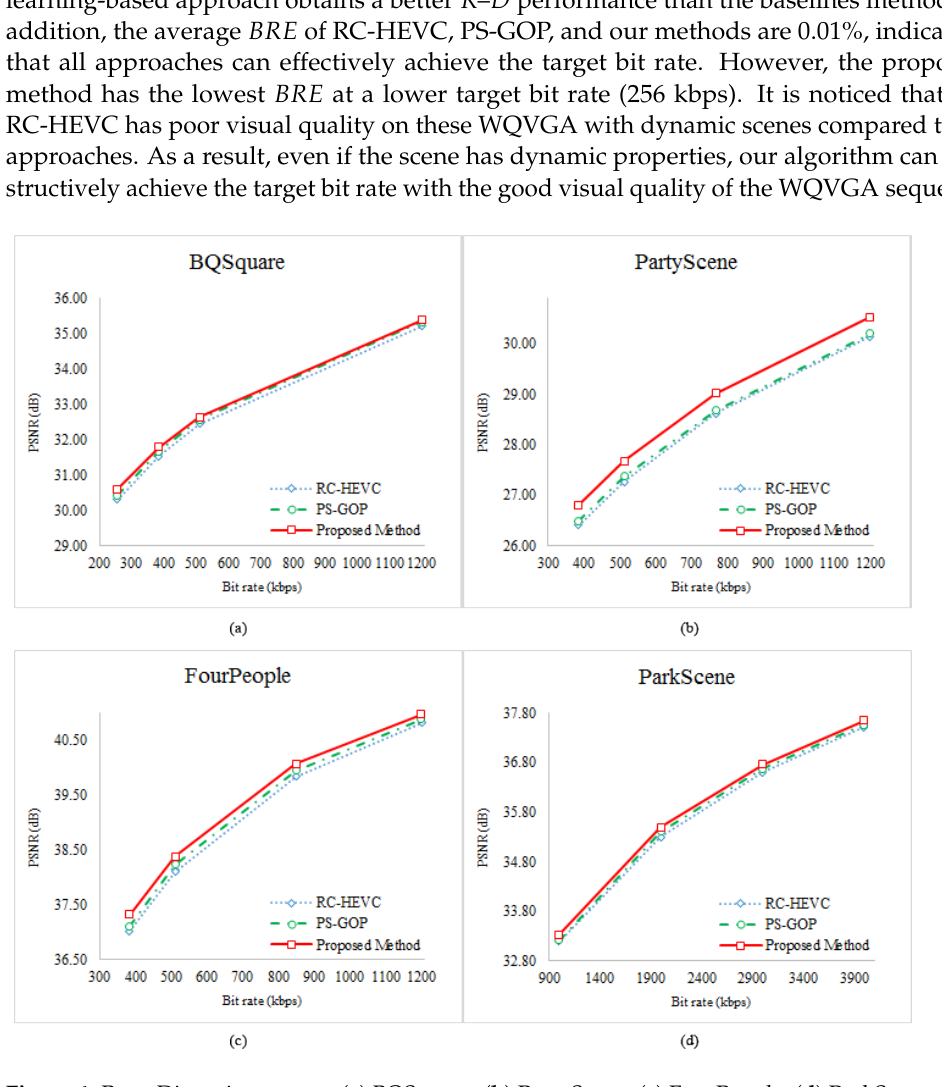
Figure 4. Rate–Distortion curves: ( a ) BQSquare, ( b ) PartyScene, ( c ) FourPeople, ( d )